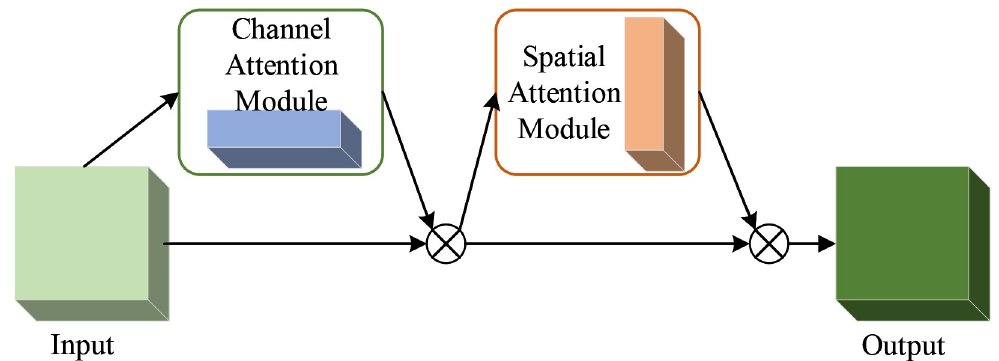
Fig 2. CBAM module